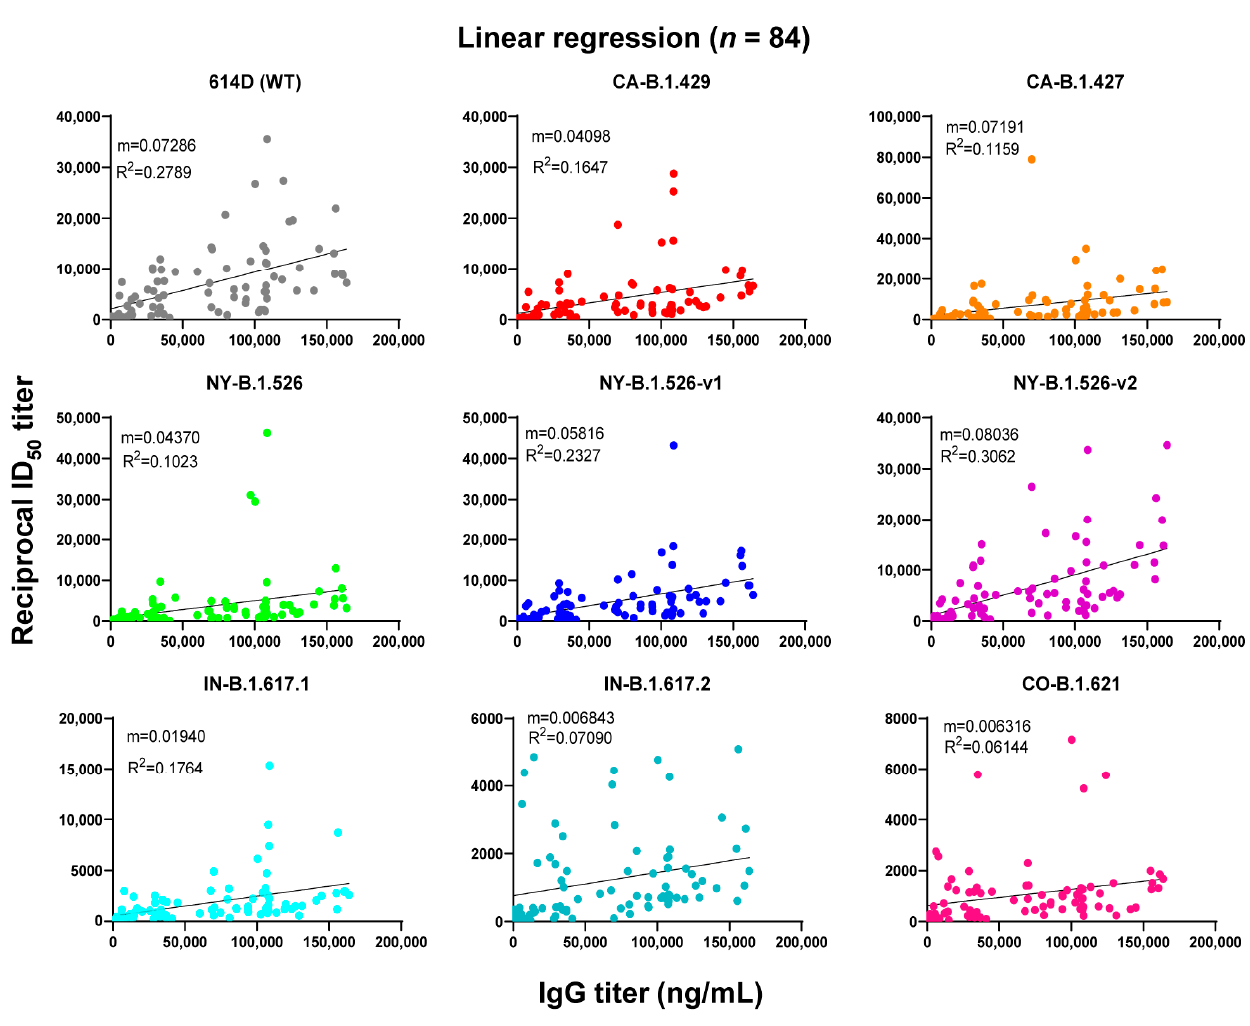
Figure 4. Linear regression for IgG titers vs. neutralizing ID 50 values for WT SARS-CoV-2 and its variants. Shown is the correlation of the neutralizing titers ID 50 (ordinate) and anti-SARS-CoV-2 spike S1 IgG levels (abscissa) of plasma from vaccinated subjects ( n = 84 for vaccine group). Each figure contains the coefficient of determination (R 2 ) as well as the slope (m). Significance was evaluated by calculating p values, which tests the null hypothesis that the slope is zero (no correlation). Linear regression analysis was performed using GraphPad Prism 9.1.1. software. Pearson’s correlation coefficients were calculated. Simple linear regression (solid line) is shown. R 2 = goodness of fit. p-values less than 0.05 are statistically significant. All p values in each regression plot are